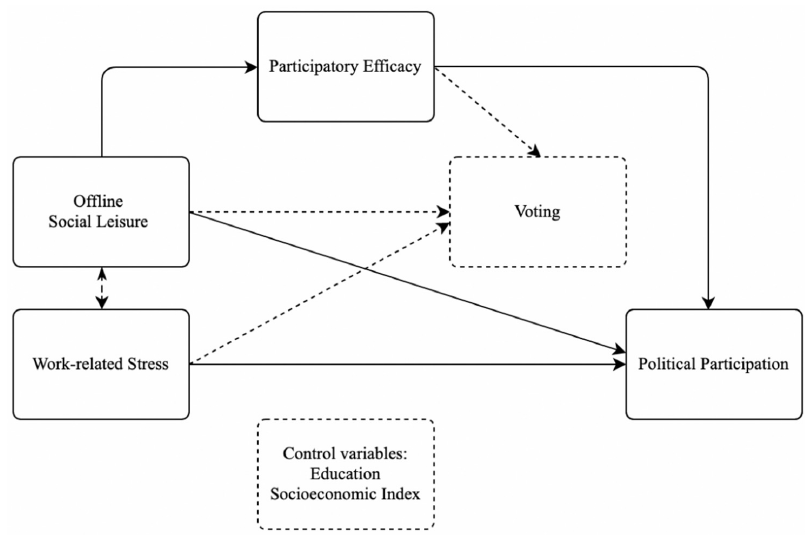
Figure 1. Conceptual model of the relationship between work-related stress/offline social leisure and political participation. H1 = first hypothesis. H2 = second hypothesis. H3 = third hypothesis. The political participation variable does not include voting. The full lines denote the main analysis pathways, whereas dotted lines represent the aims for exploratory